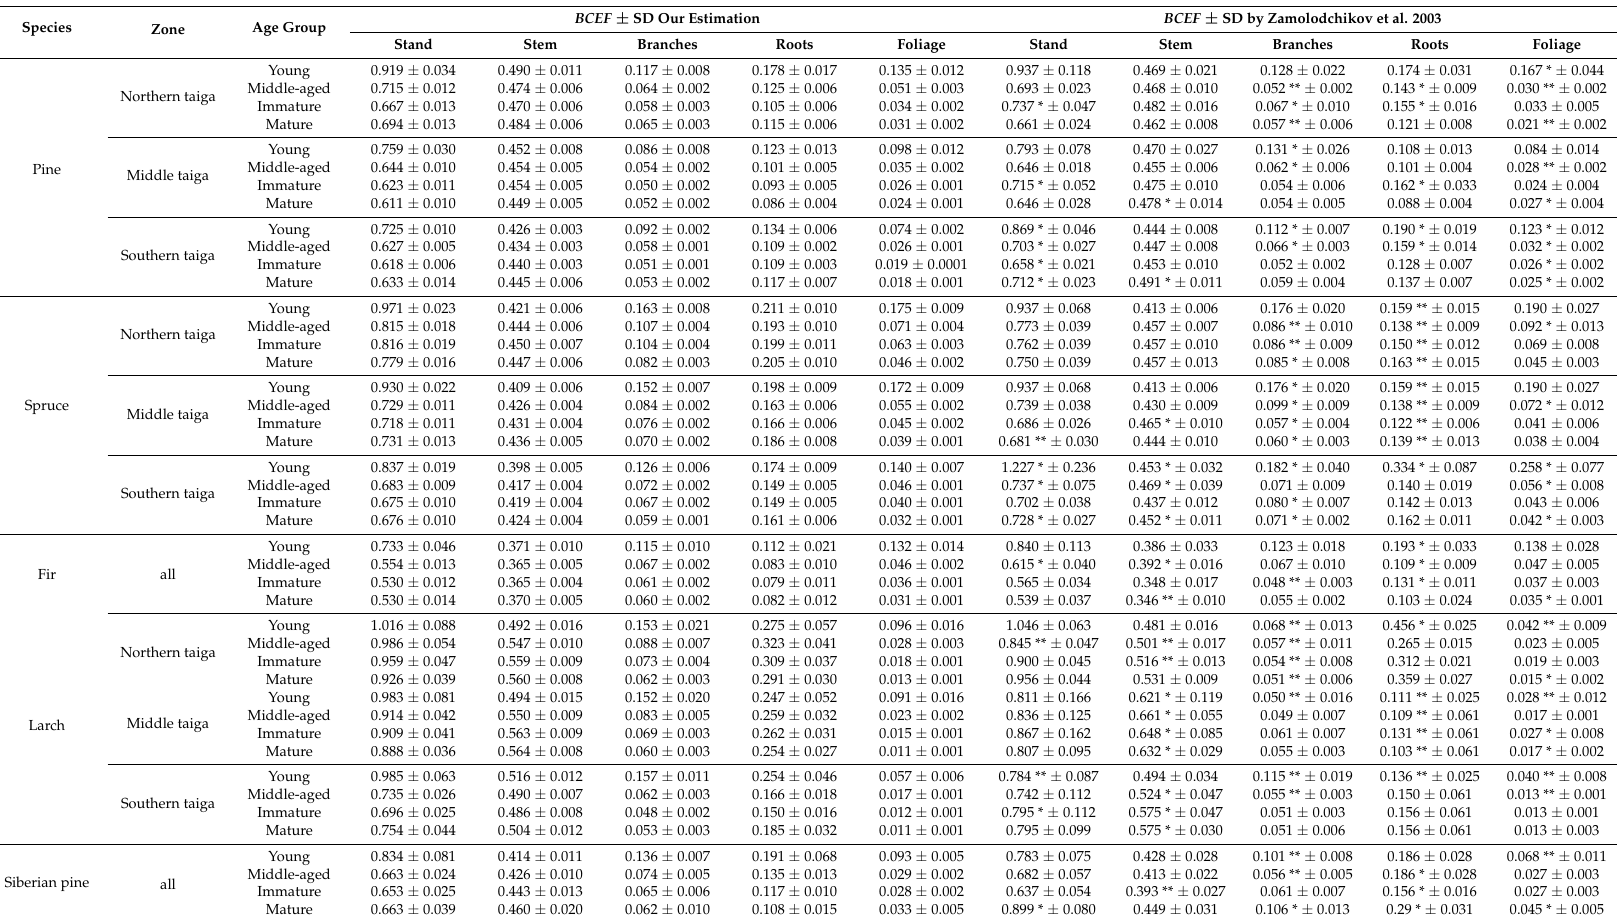
Table A3. Comparison of biomass conversion and expansion factors (t m − 3 ) estimated in this study with those of Zamolodchikov et al. (2003). Species